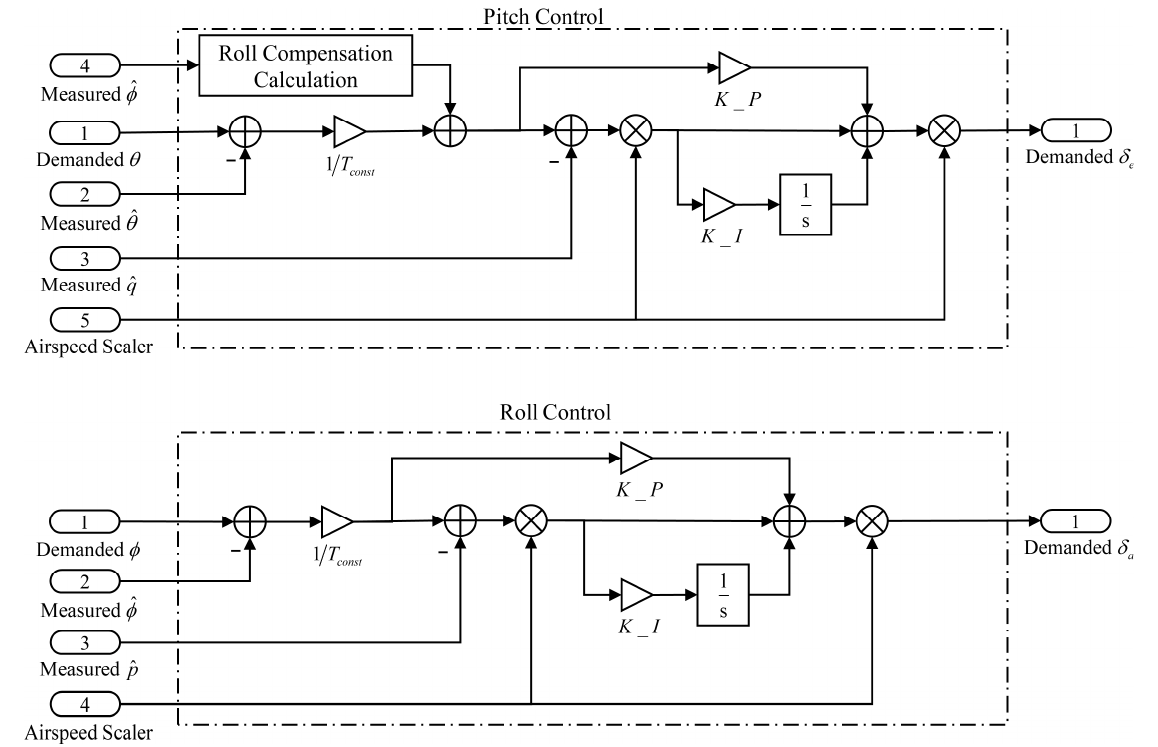
Figure 7. Attitude control loop schematic diagram.